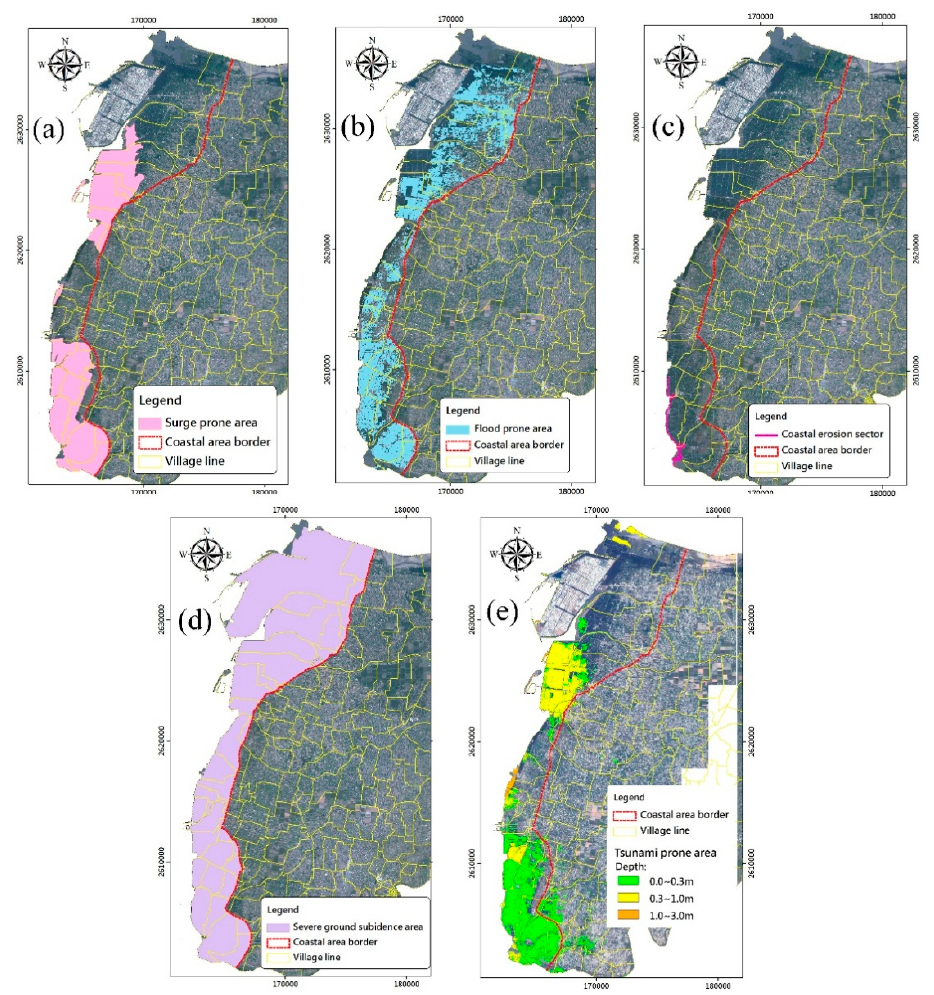
Figure 4. GIS layers of the coastal hazard-prone areas in Yunlin County, consisting of ( a ) surge, ( b ) flood, ( c ) erosion, ( d ) ground subsidence, and ( e ) tsunami prone area layers.